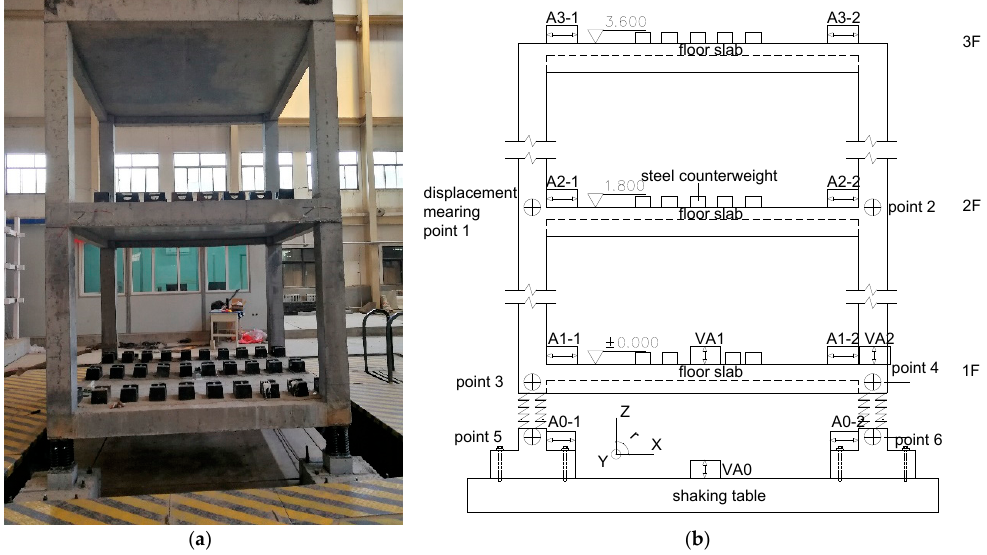
Figure 12. Elevation of the experimental model: ( a ) photo of asphalt-spring three-dimensional isolation structures; ( b ) geometry of asphalt-spring three-dimensional isolation structures.